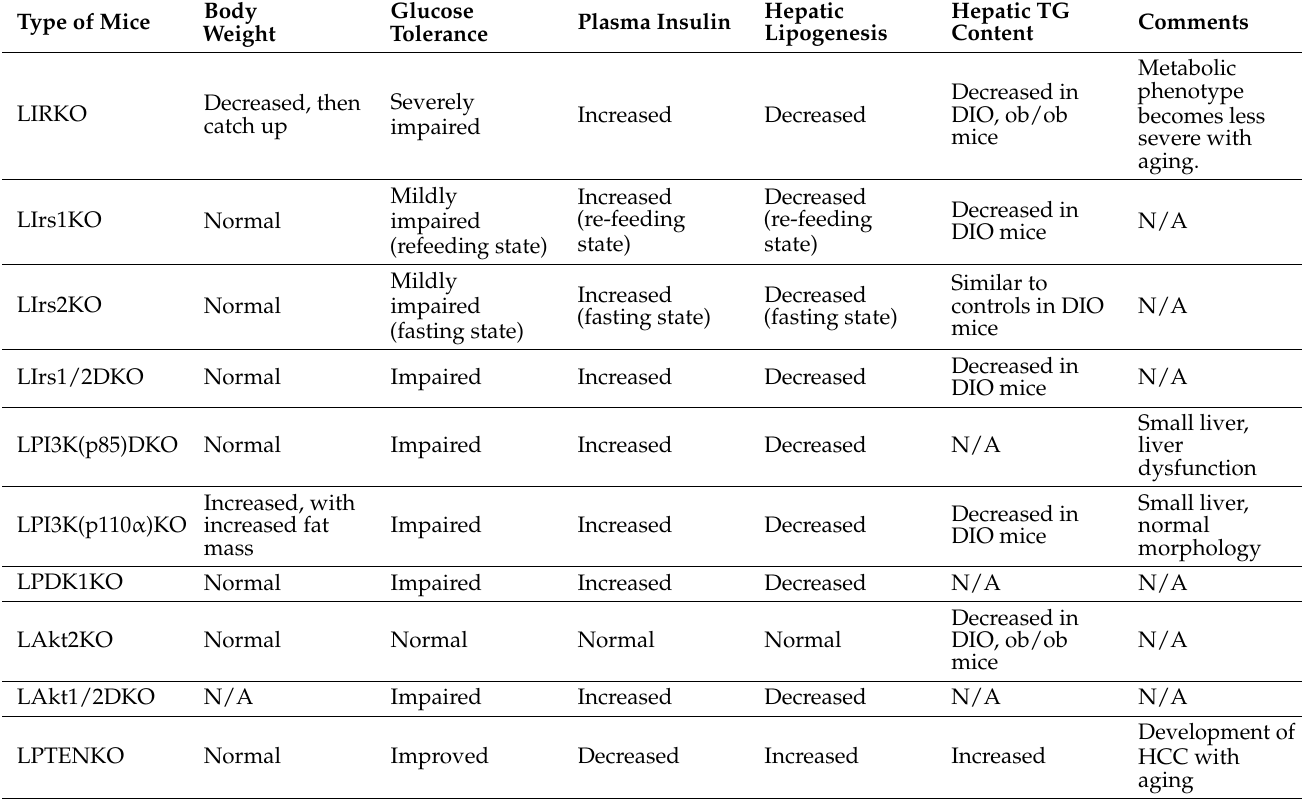
Table 1. Summary of genetically modified mouse models of insulin signaling. (N/A: not